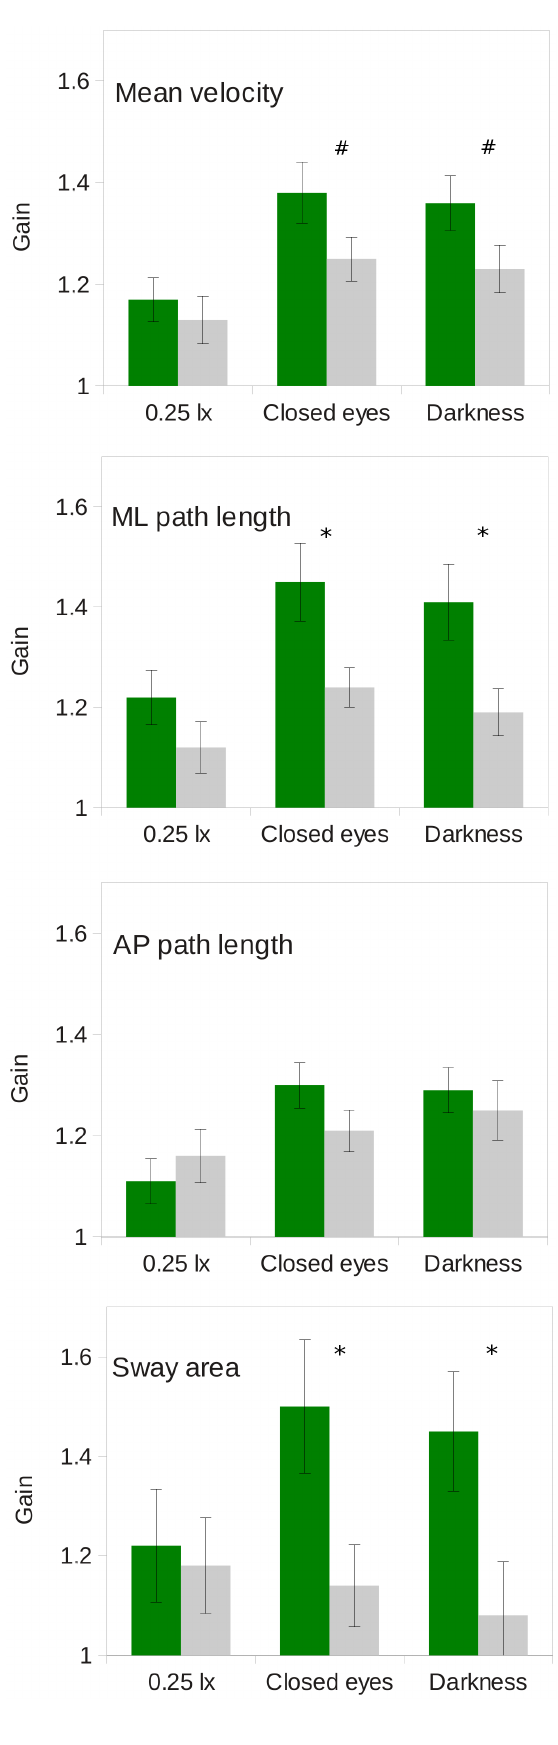
Figure 2. Gains in postural sway. Gains in postural sway expressed as the quotients between the normal light eyes opened conditions to the (1) very low illumination, (2) eyes closed and (3) total darkness conditions for the young participants (dark green) and the elderly participants (light grey). * indicates a significant difference between the two age groups at p , 0.05, and # indicates marginal significance at 0.05 , p ,